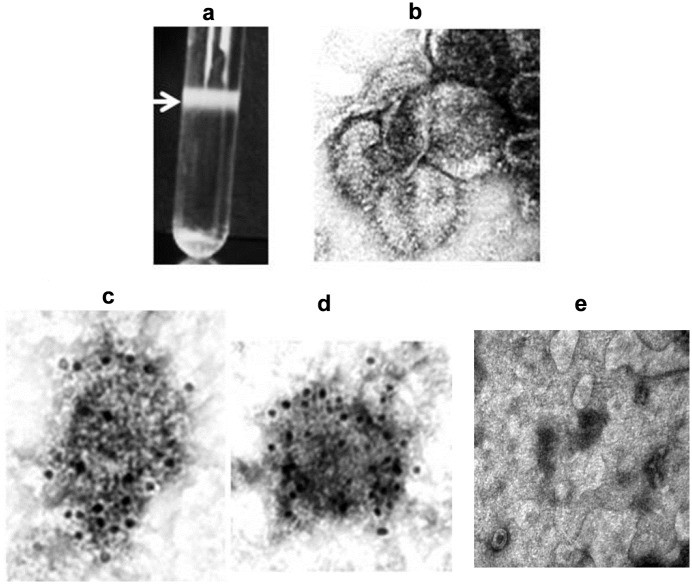
Co-expression of G, F and M proteins resulted in large quantities of RSV VLPs which were functionally assembled and immunoreactive: VLPs were purified as described, viewed by EM to evaluate their morphology and stained by immunogold-labelling technique to test for immune reactivity.(a) Arrow points to VLP-containing band in the sucrose gradient. (b) Several negatively stained particles resembling the parental virus; surface glycoproteins are easily seen. They resemble those reported for parental RSV by TEM (John Barr Lab., Leeds University, UK). (c) Immunoreactive gold-labelled particles stained with polyclonal RSV antibody and (d) those stained with RSV-F specific primary antibody are clearly seen. (e) Is a negative control where the primary antibody was omitted and VLPs were stained only with the gold-labelled secondary antibody.